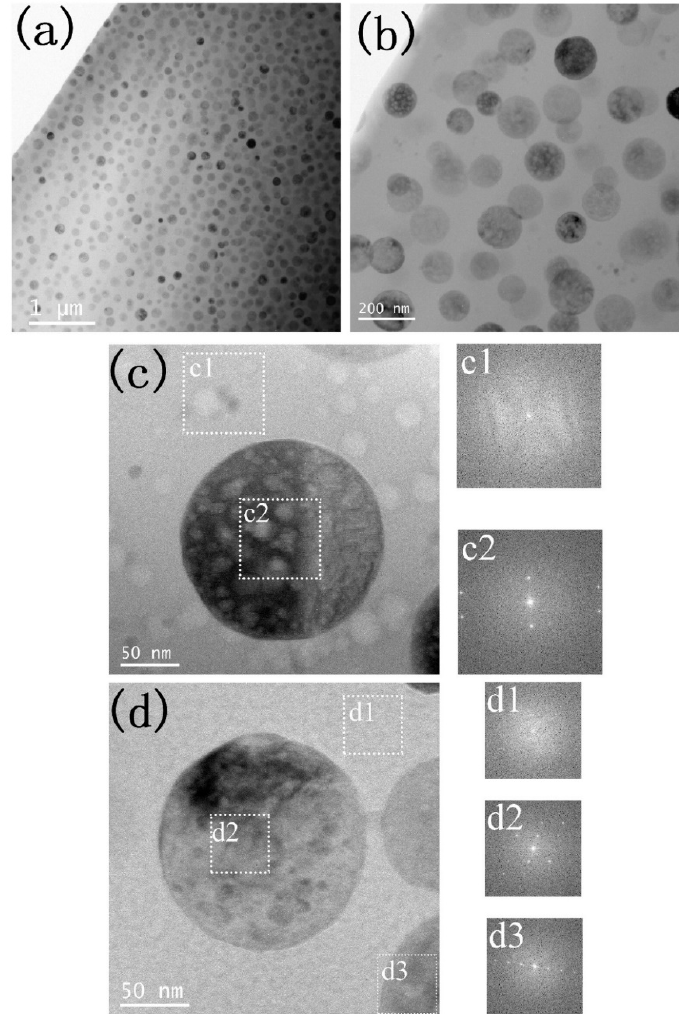
Figure 4. XTEM micrographs of GC1 sample before and after He + ion irradiation. ( a ) smaller magnification of cross-sectional layer, ( b ) Enlarged magnification of cross-sectional layer, ( c ) high-magnification image from the irradiation layer and the fast Fourier transform (FFT) from corresponding regions; and ( d ) high-magnification image from the unirradiation layer and corresponding FFT on selected regions.